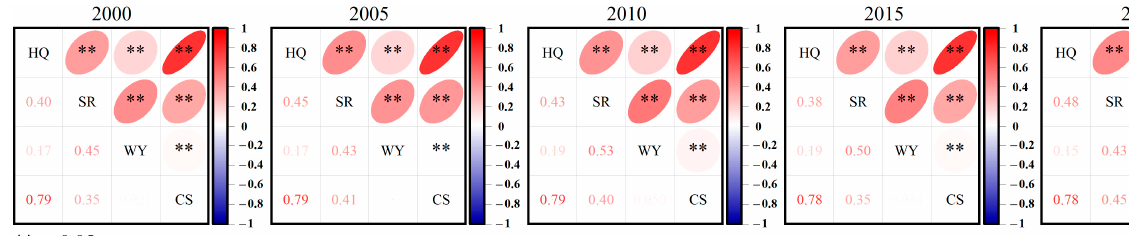
Figure 3. Spatial patterns of different ESs from 2000 to 2020 in the Tianshan Mountains. Note: HQ is habitat quality; SR is soil retention; WY is water yield; CS is carbon storage.